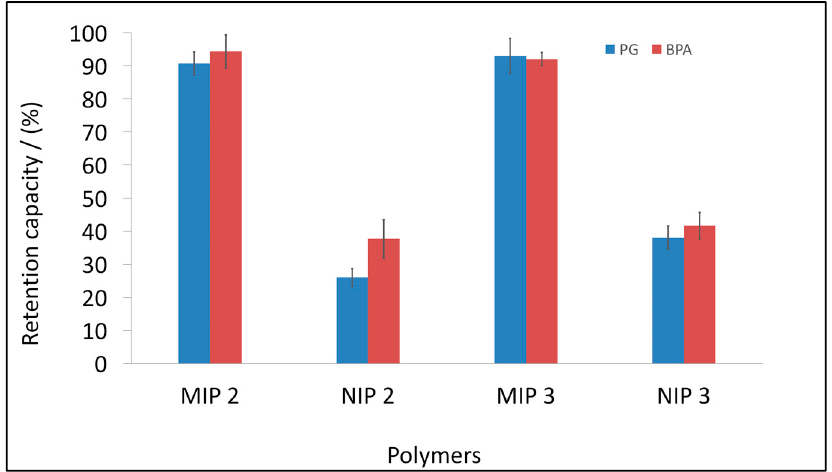
Figure 5. Retention of PG and BPA for two selected MIPs and NIPs. The concentration of PG was 5.28 mg/L and the concentration of BPA was 3.12 mg/L. Error bars represent ±1 standard deviation. Experiments were performed in triplicate.